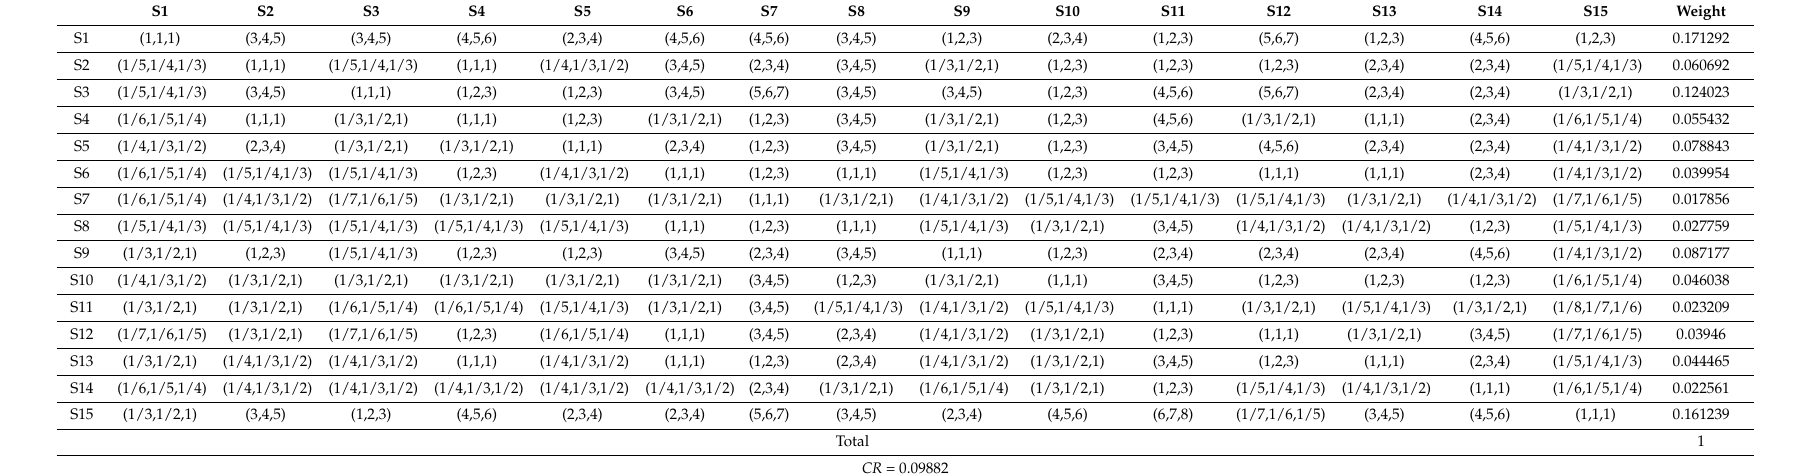
Table 11. Comparision matrix of A1 based on